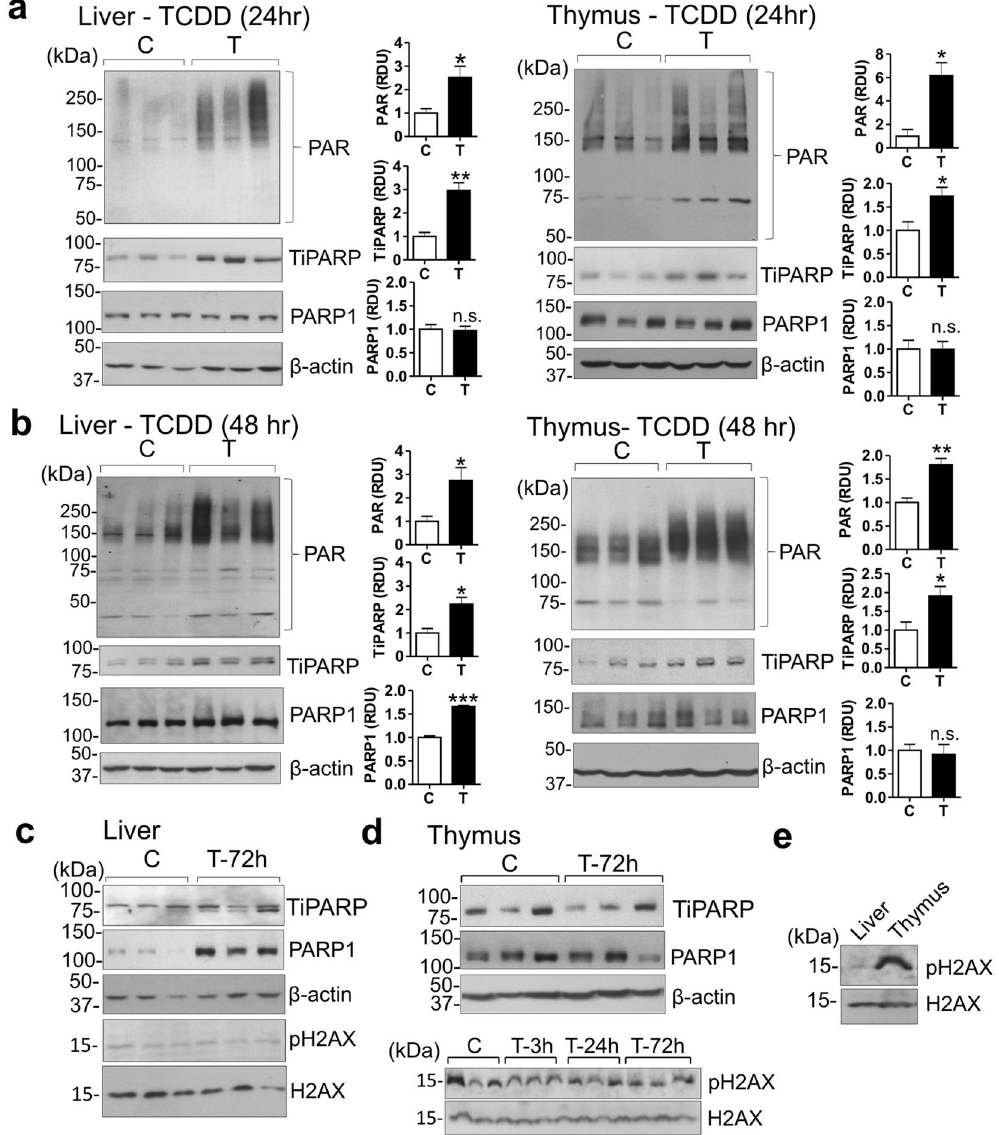
Figure 2. TCDD increases PARP activity in vivo . ( a–d ) Western blots on homogenates of liver and thymus from CE treated with TCDD (T) or vehicle (C). Bar graphs show means ± SE for relative densitometry units (RDU) for triplicate lanes. ( e ) pH2AX levels in liver and thymus from untreated CE. For western blots for CE homogenates in this and other Figures, each lane is from an individual